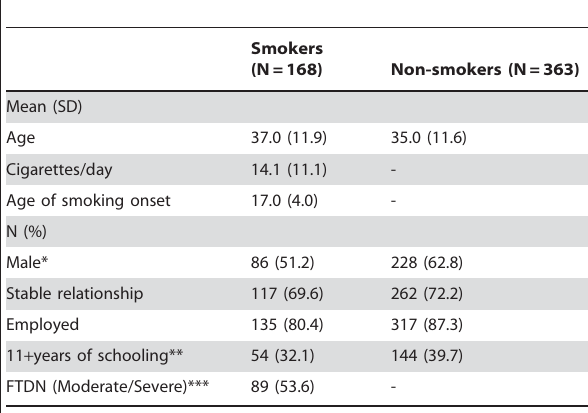
Table 1. Demographic characteristics of study